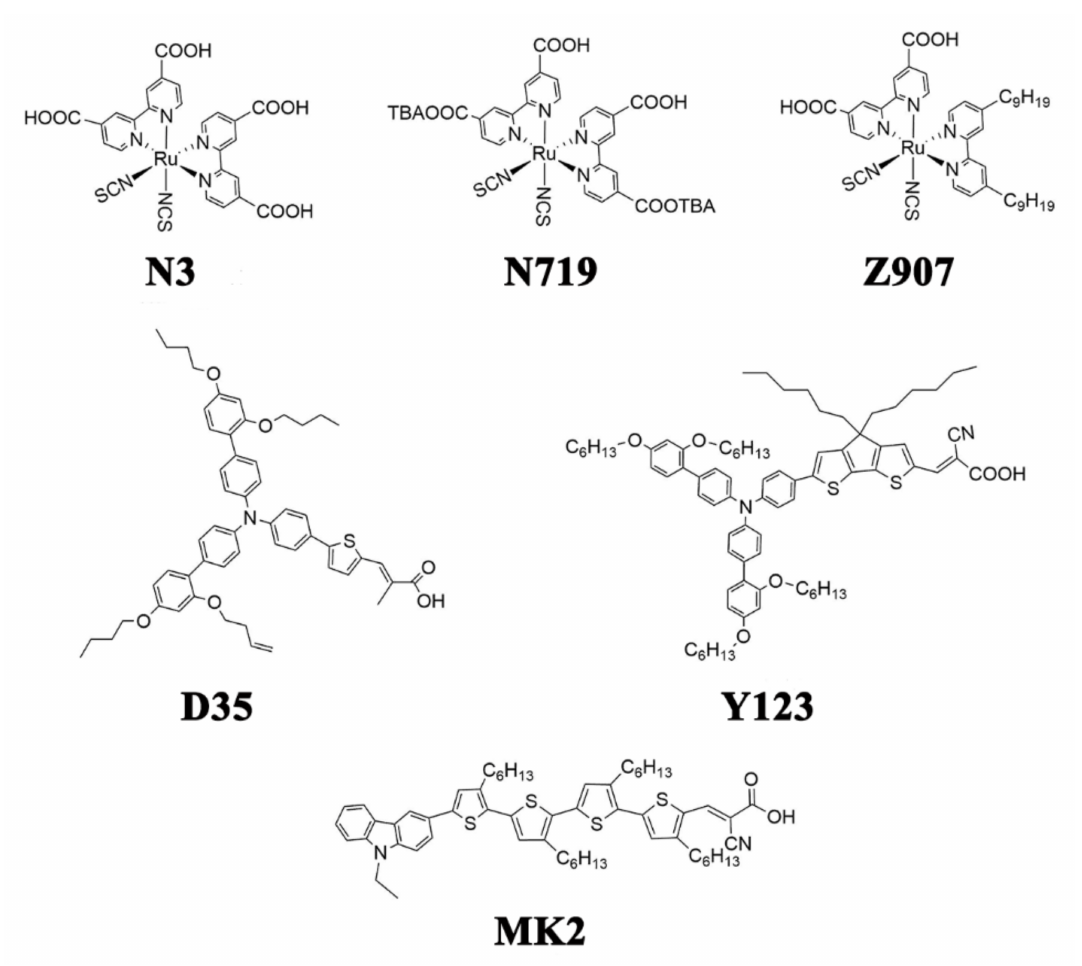
Figure 3. Some of the most popular inorganic and organic dyes used in DSSCs [1,26–28]. Following charge injection in the semiconductor, the oxidized dye S + is generated, which needs to be reduced before electron recombination occurs. The redox mediator is essential to regenerate the reduced form of the sensitizer S, finally closing the entire cycle by collecting the electron at the counter electrode (Equations (3) and (4)).